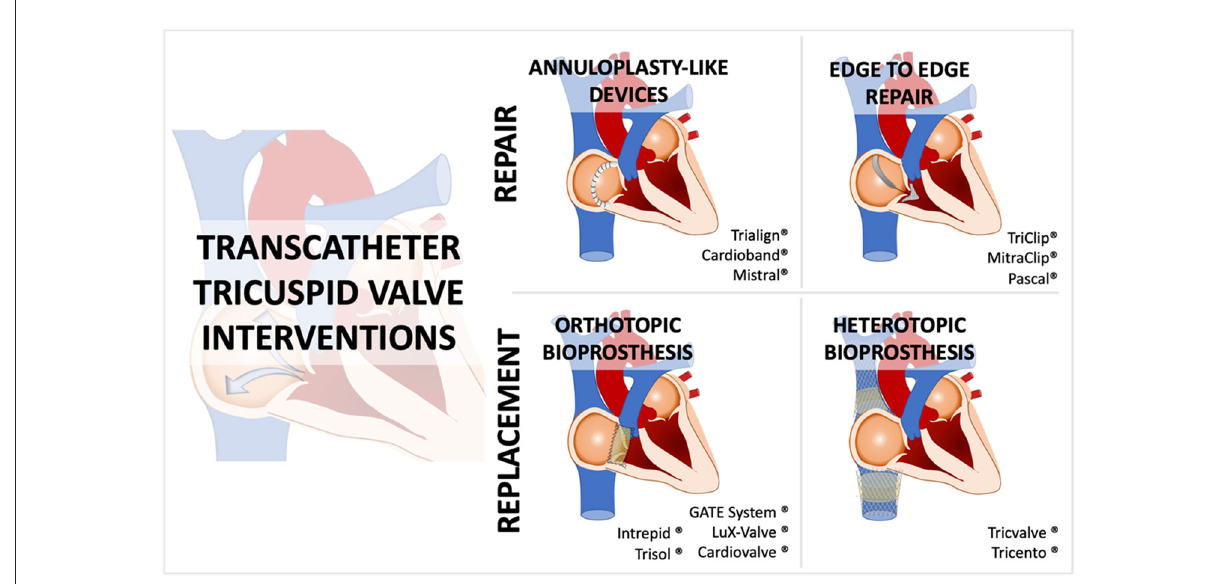
FIGURE4 Overview of the several devices and their mechanism of action in the transcatheter tricuspid valve intervention field.